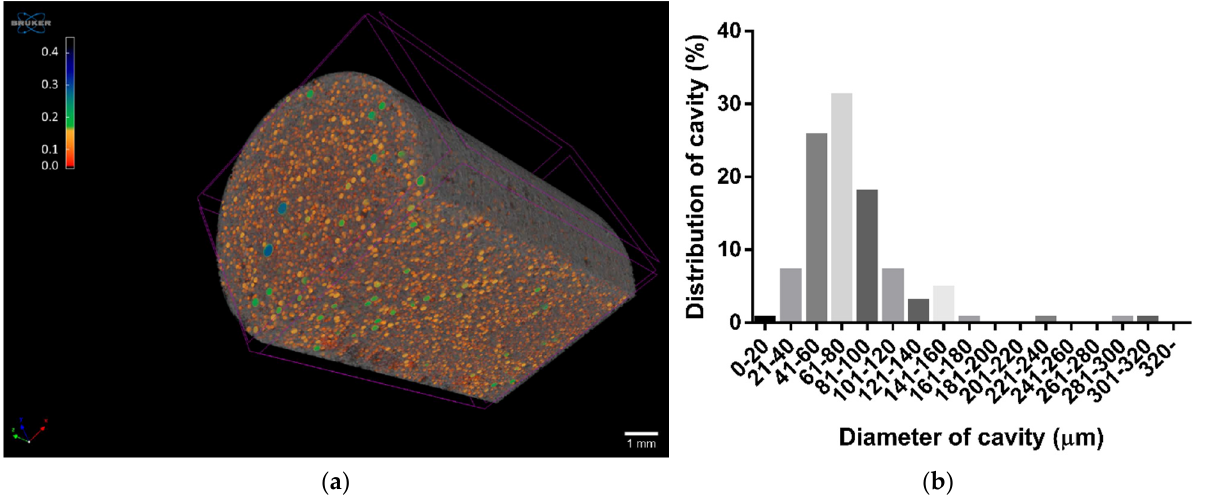
Figure 6. Reconstructed micro-CT image of the V2 composition ( a ) and cavity size distribution ( b ). The reconstructed model of the foam structure shows a closed spheroid cell structure,